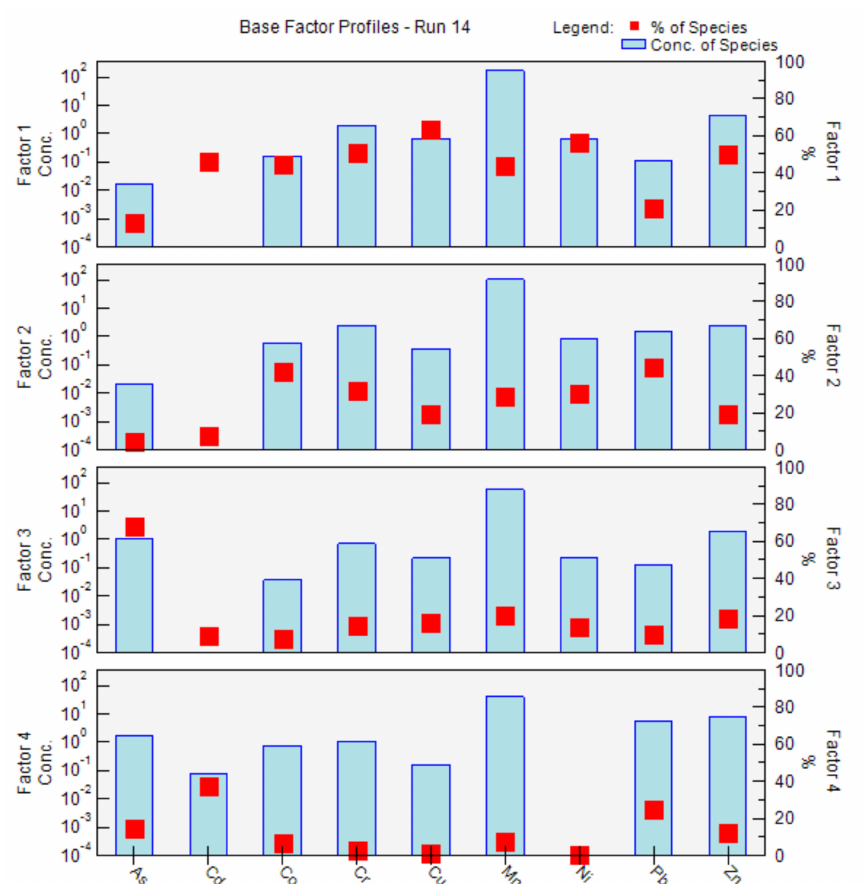
Figure 6. Factors profiles and source contributions of heavy metals from the positive matrix factor analysis (PMF)